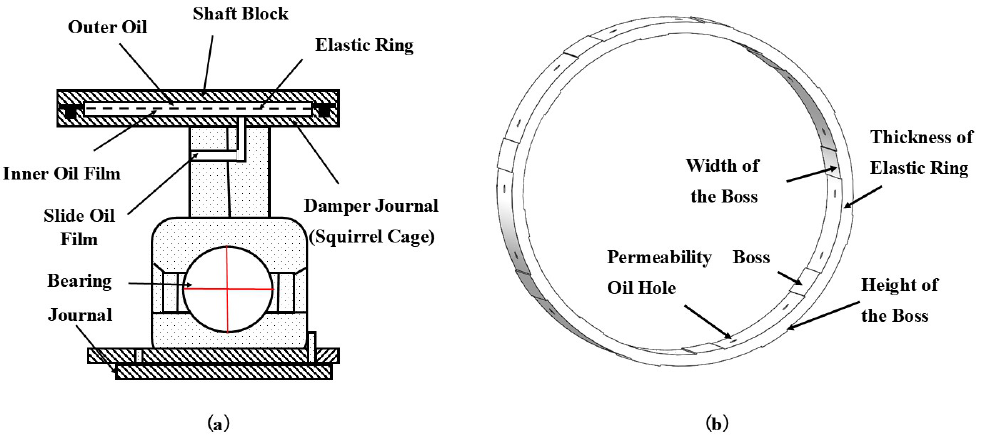
Figure 1. Structure diagram of ERSFD. ( a ) Composite structure. ( b ) Elstic ring structure.